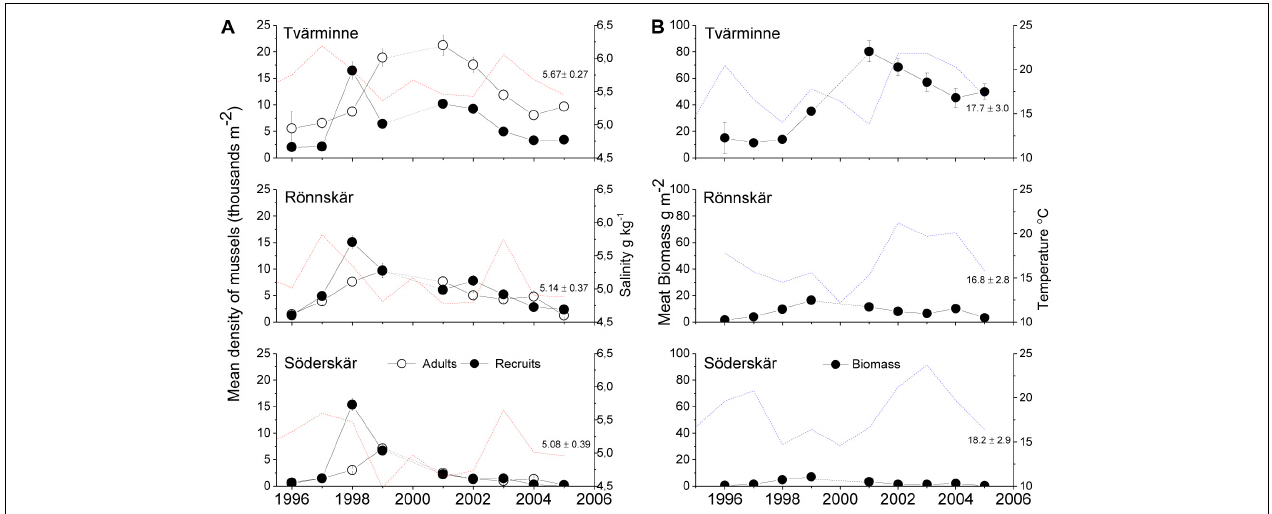
FIGURE 3 | Mean density ( ± SE) of adult mussels and recruits at the three study areas (A) 1996–2005 and concomitant changes in salinity and temperature. Salinity (May) and temperatures changes (August) during the study period are also shown, as well as mean ± SD for the entire period). Mean ( ± SE) biomass at the three study areas is shown in the right panel (B) . Between 1995 and 2005 salinity was higher at Tvärminne compared to Rönnskär and Söderskär (ANOVA, F 2 , 27 = 11.1, P < 0.001), whereas temperature (1996–2005, as RO lacked temperature data in 1995) was similar among areas (ANOVA, F 2 , 24 = 0.74, P = 0.5).A clear spatial tipping point is seen between TV and RÖ where long-term salinity declines by ca 0.5 g kg − 1 , but shows a > 5-fold drop in average biomass.